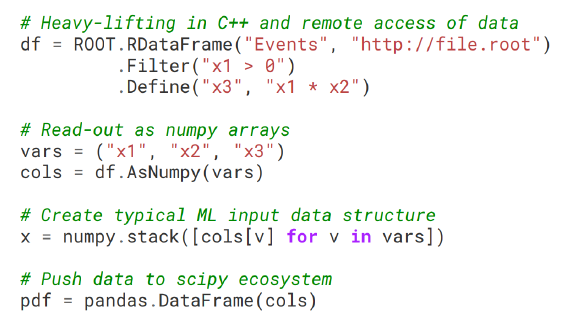
Figure 1. Usage of the AsNumpy feature as part of the RDataFrame infrastructure to load data in ROOT files to memory as NumPy